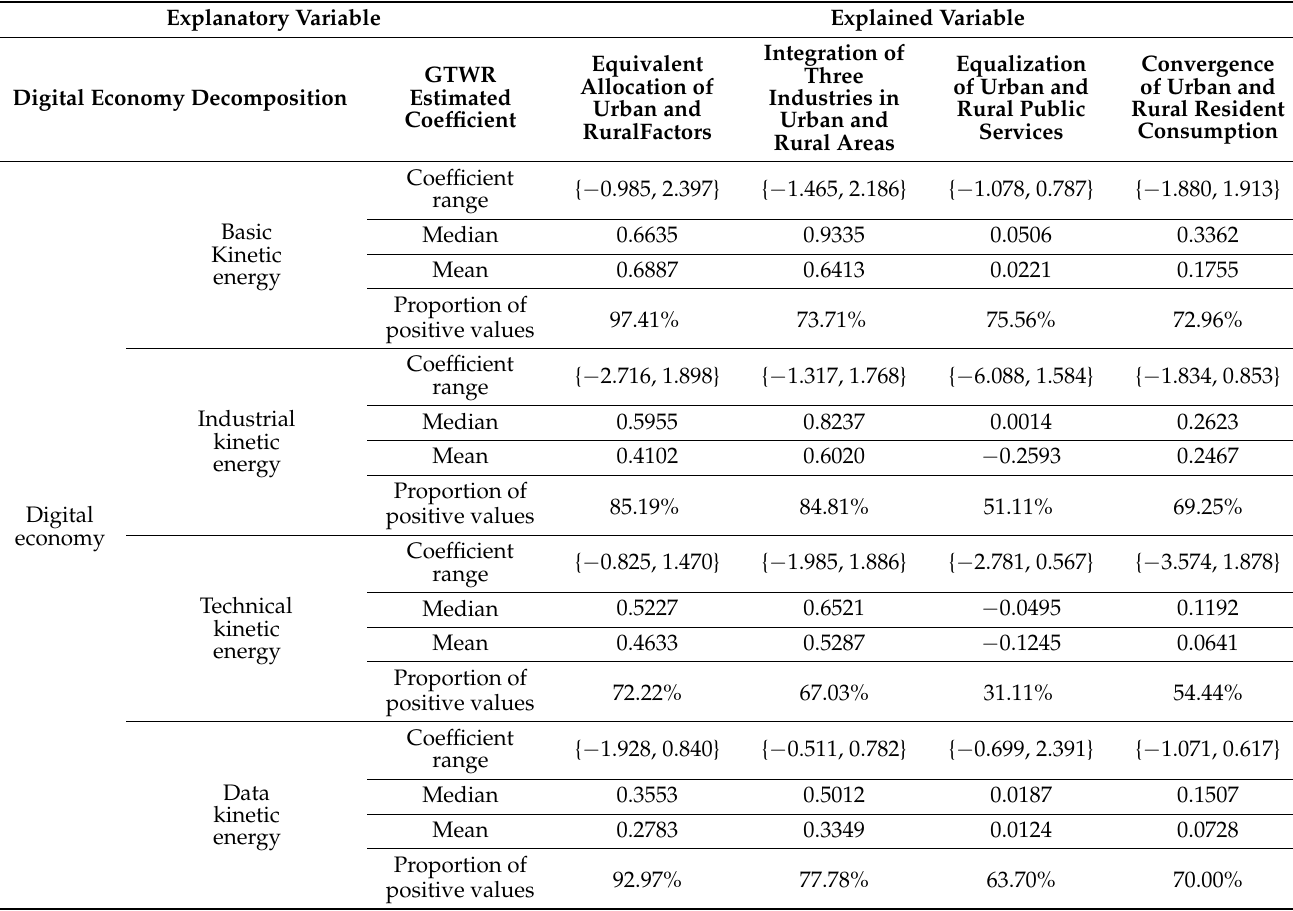
Table 6. Spatial effect decomposition of the digital